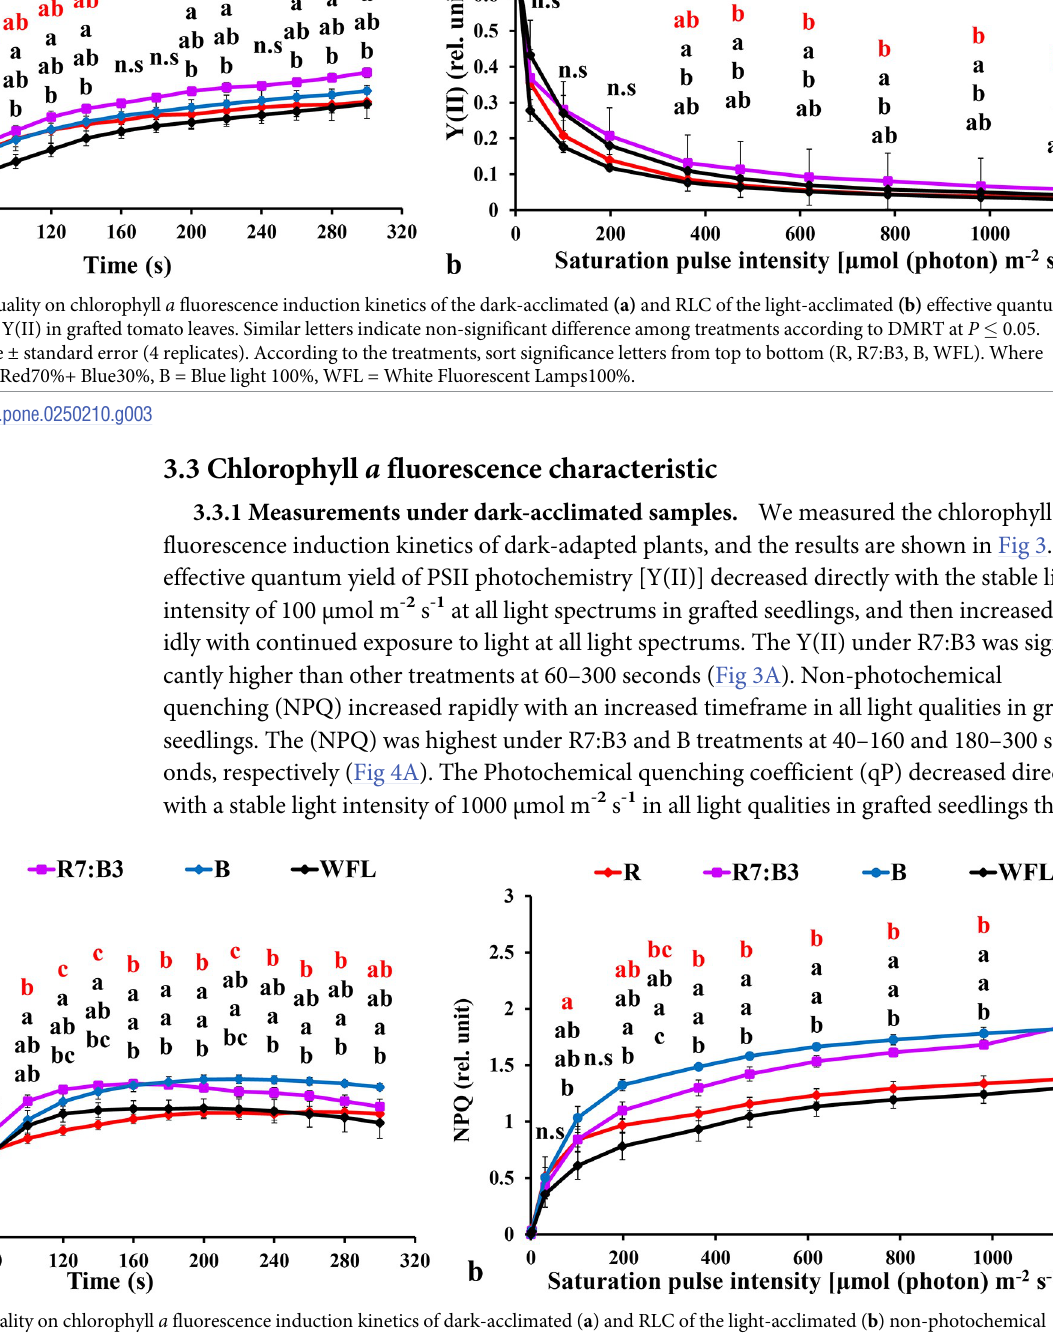
PLOS ONE | https://doi.org/10.1371/journal.pone.0250210 May 7,